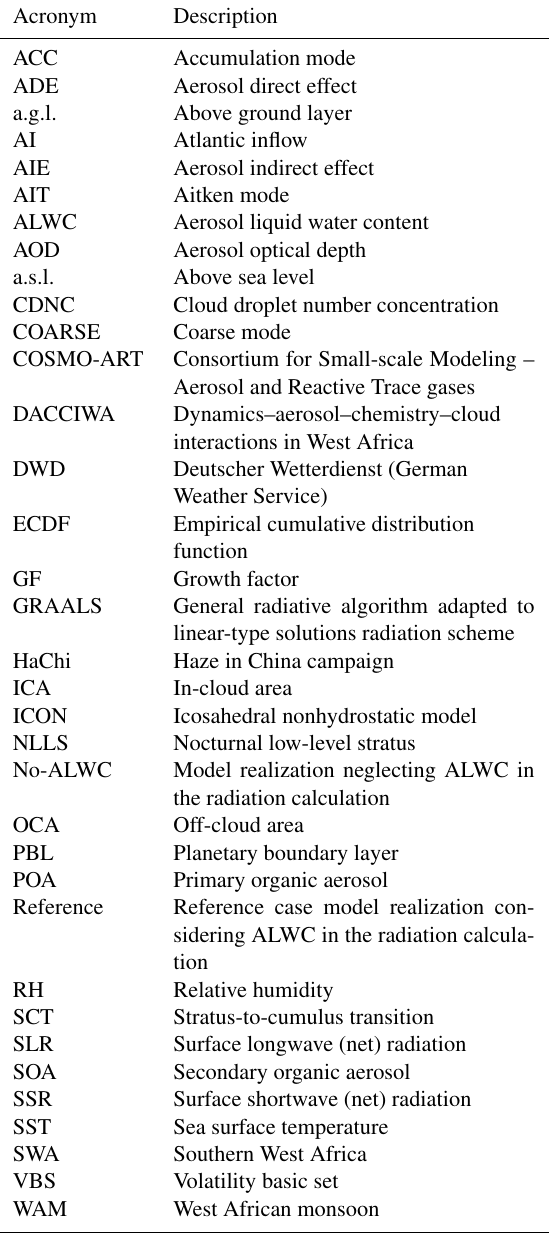
Table 1. List of acronyms used in this